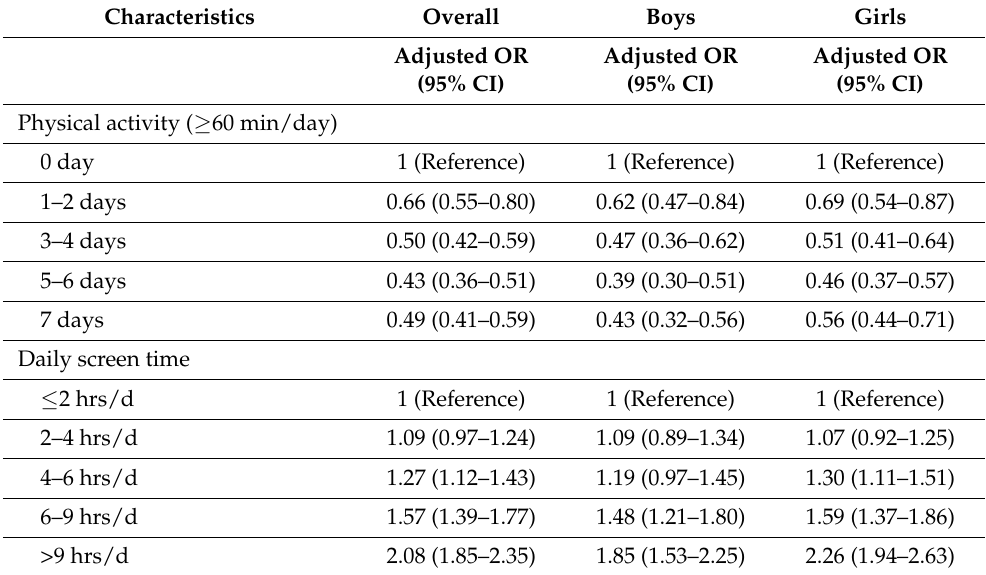
Table 2. Adjusted associations between physical activity, screen time, and frequent psychosomatic complaints in Canadian adolescents, HBSC